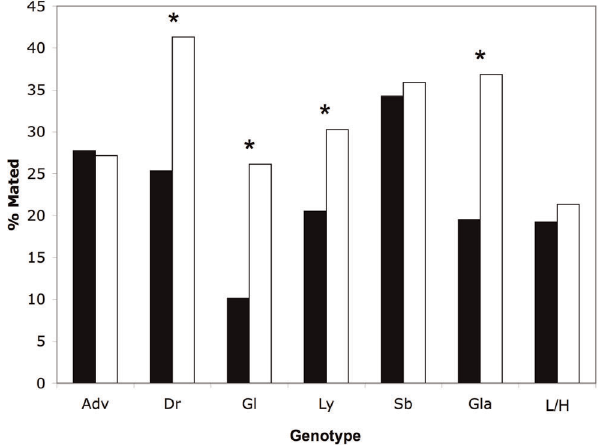
Figure 3. Relative mating success of mutant and wild-type males. Mating was deemed successful when mutant or wild-type males achieved copulation with a nonvirgin female; unsuccessful matings occurred when males failed to copulate. Black bars represent mutant (or low condition, L) males; white bars depict wild-type (or high condition, H) males. Mutant-wild-type pairs are presented according to mutant genotype. Significant differences are indicated by an asterisk.